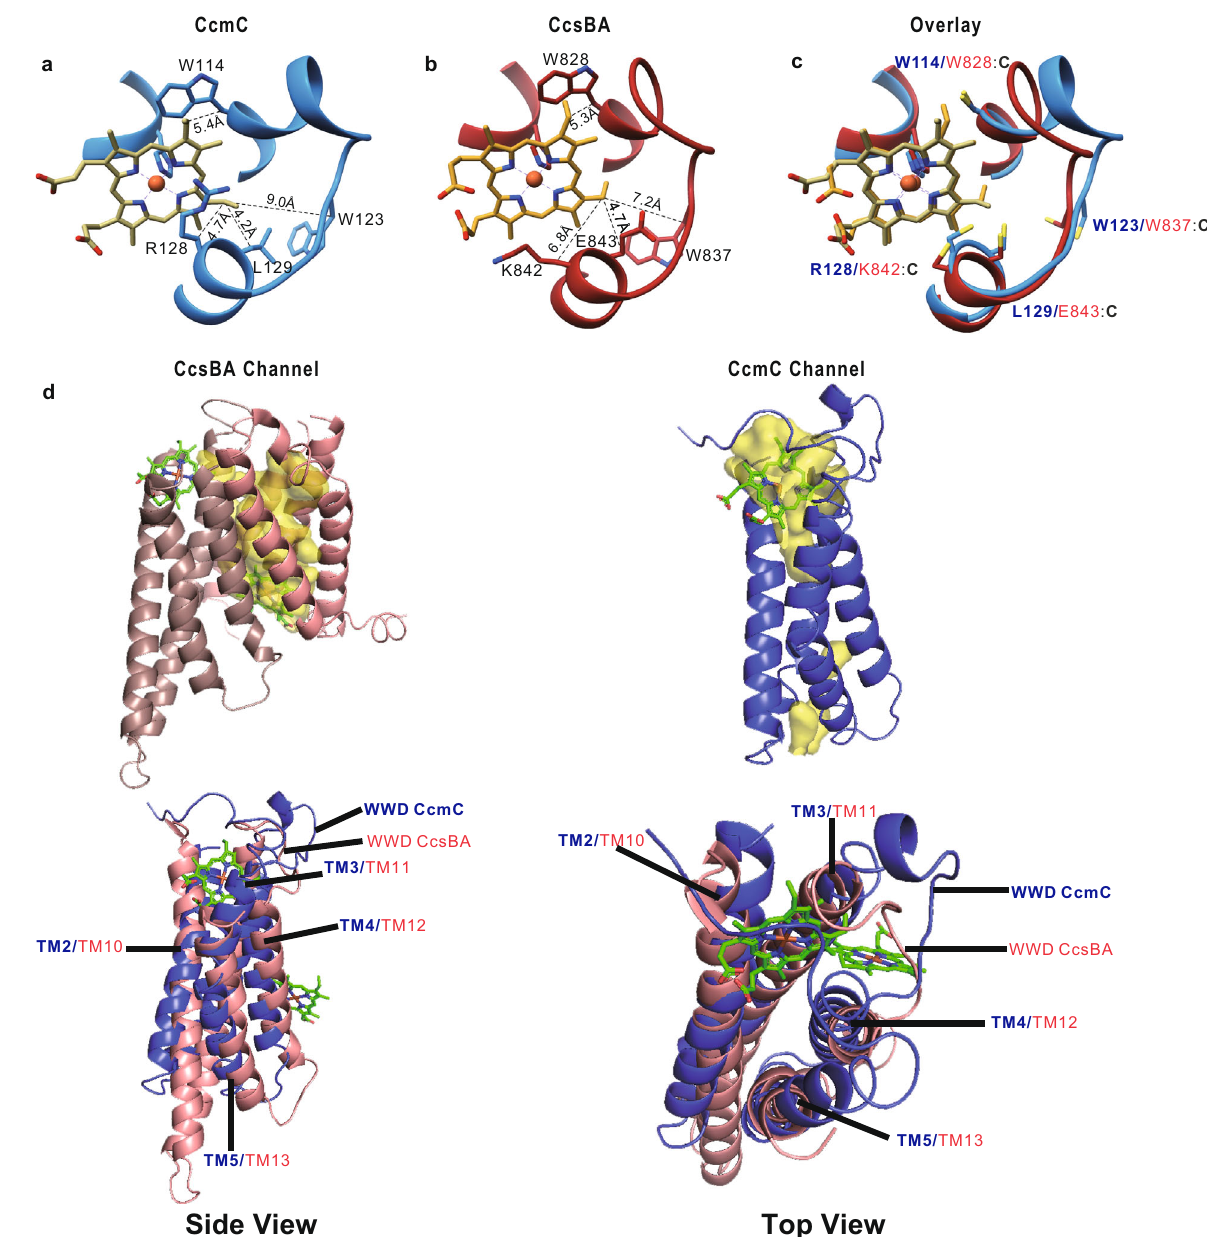
Fig. 5 | Selected views of CcmC and CcsBA structures displaying WWD domain and potential heme channels. a CcmC WWD domain and heme with residues known to crosslink to heme shown with their distances to respective heme vinyl groups labeled. b CcsBAWWD domainand heme with residues known tocrosslink to heme shown with their distances to respective heme vinyl groups labeled. c CcmC (blue) and CcsBA (red) WWD domain overlayed upon one another